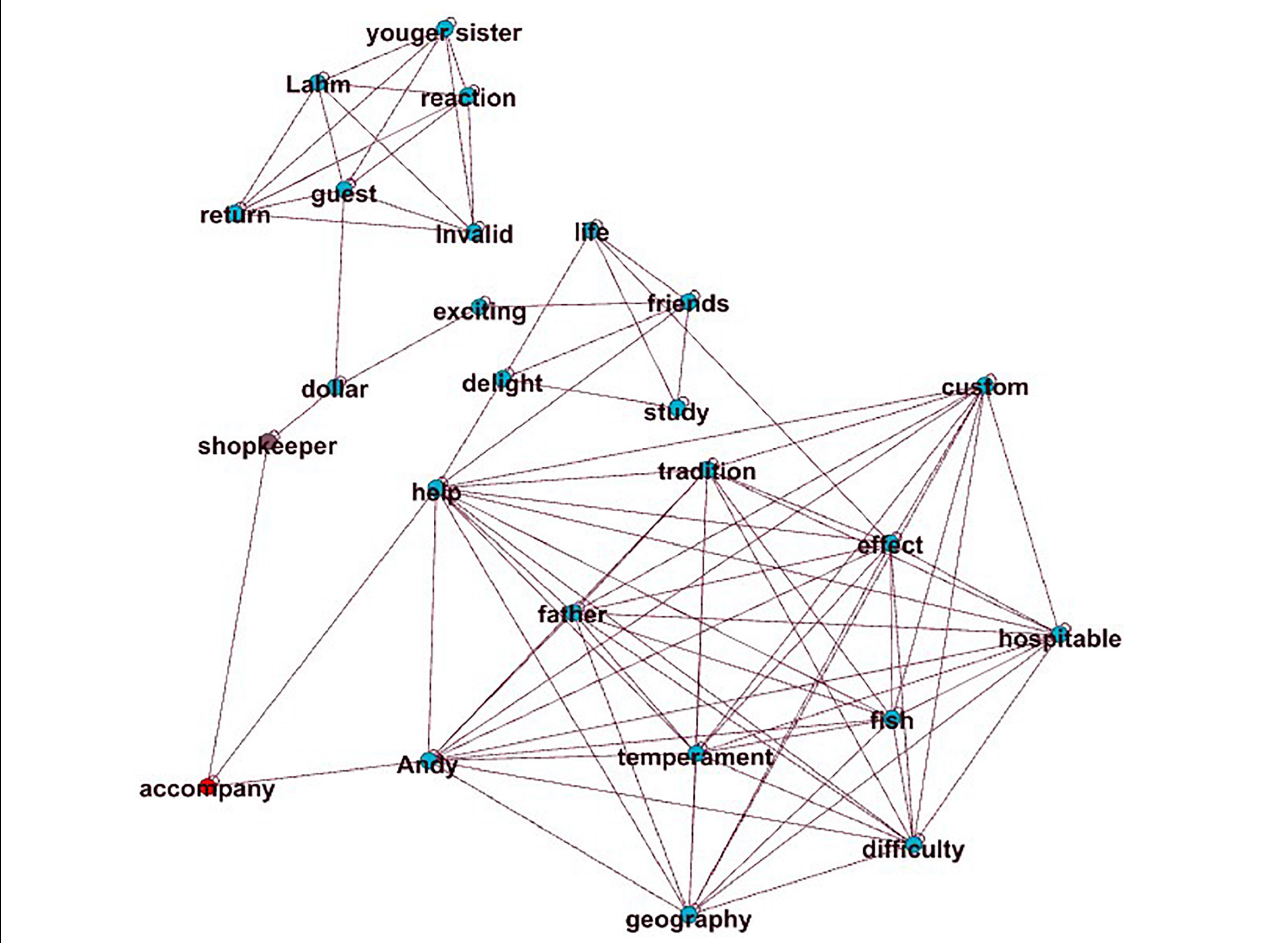
FIGURE 5 | Low-level